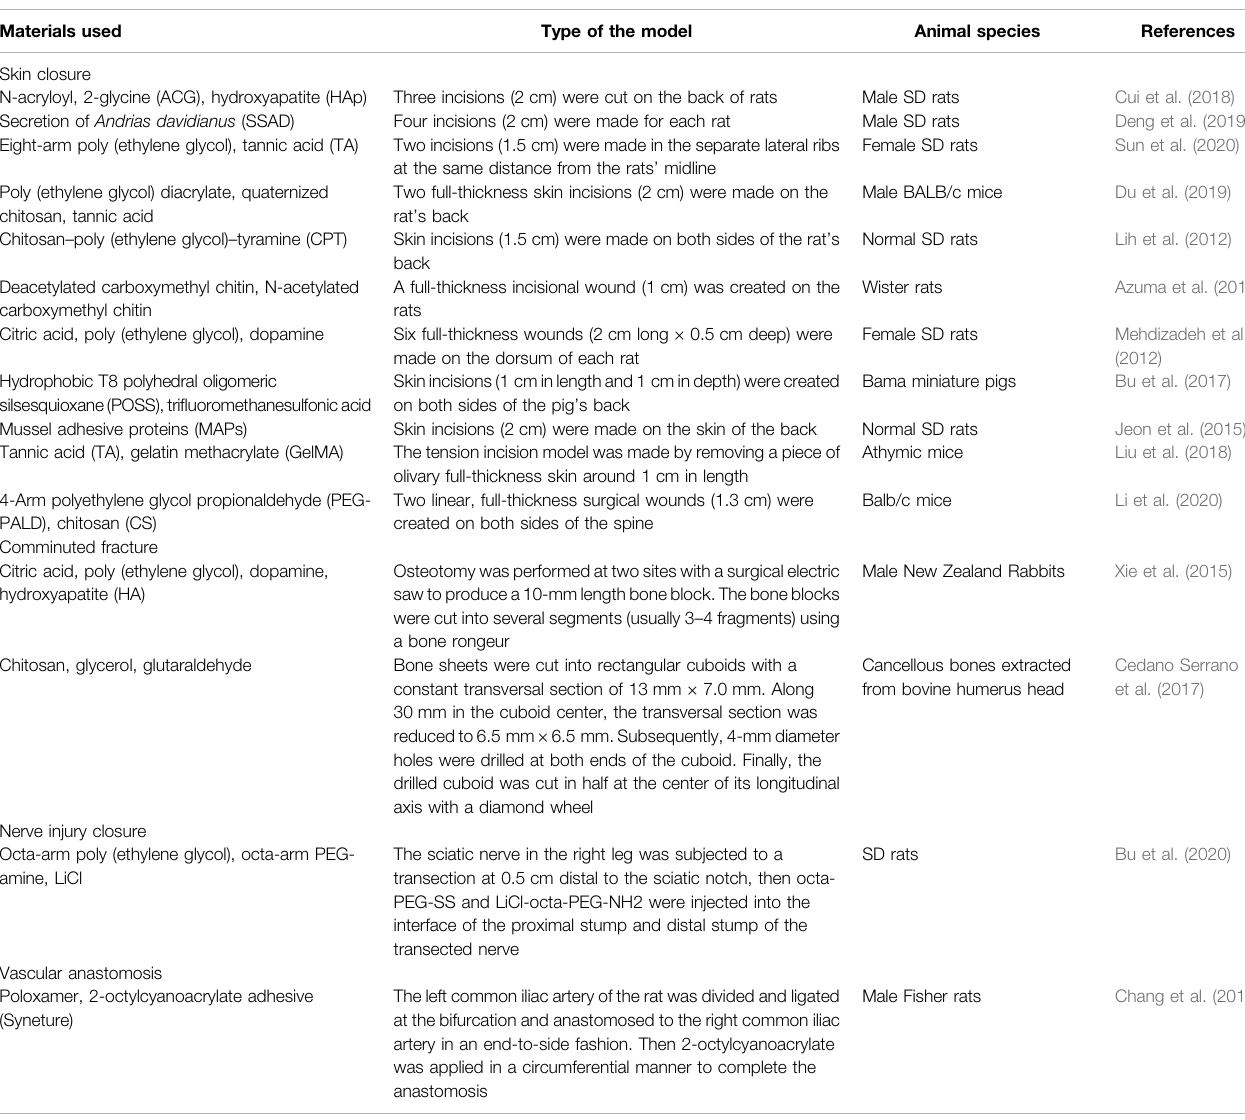
TABLE 1 | Bioadhesives for wound closure. Materials